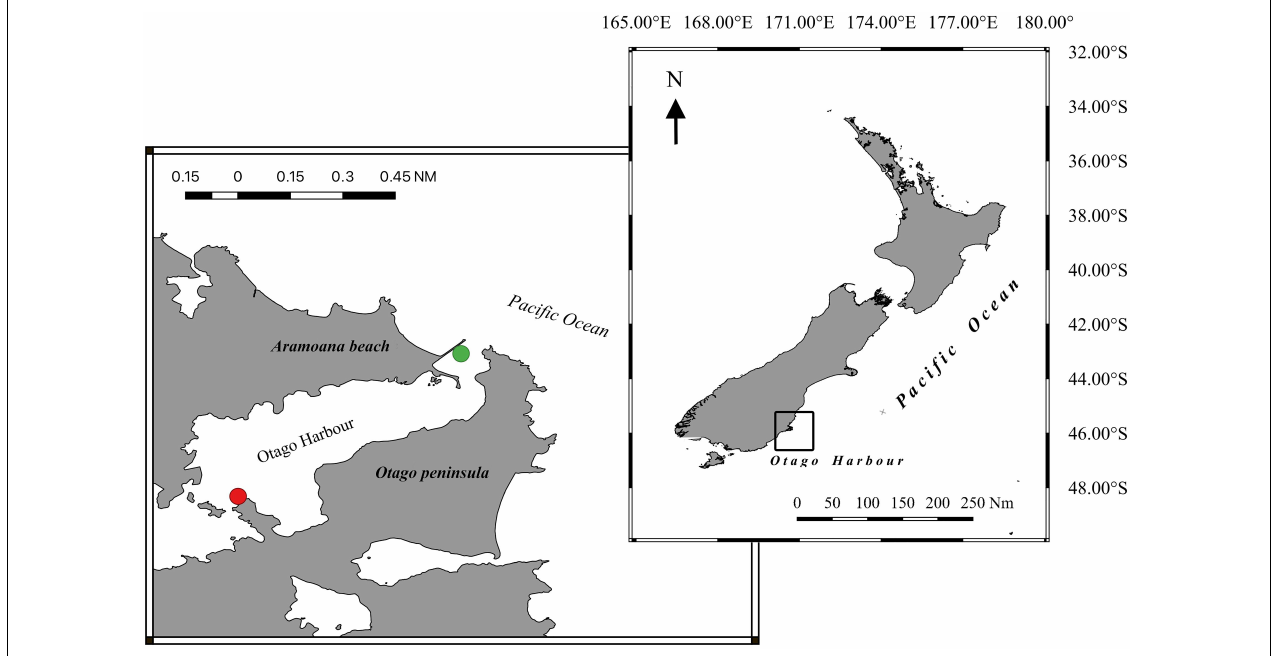
FIGURE 1 | Locations used to collect krill inside the Otago Harbour, New Zealand. (Green dot) Aramoana point. (Red dot) Portobello Marine